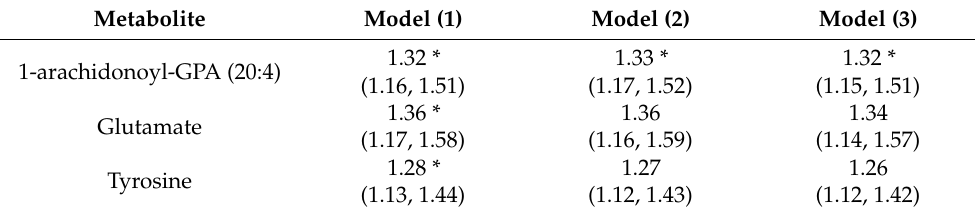
Table 2. Logistic Regression Analysis of 640 Single Metabolites.